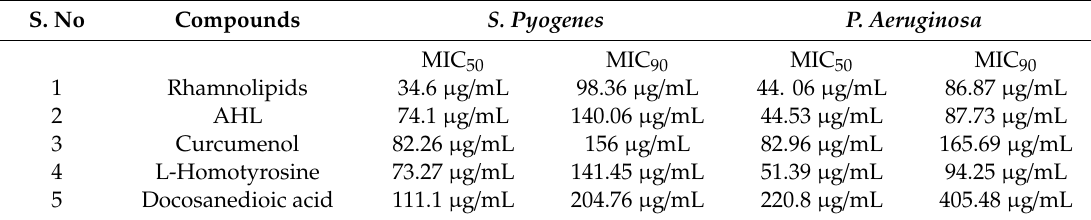
Table 1. MIC 50 and MIC 90 values of pure compounds against Gram-positive and Gram-negative